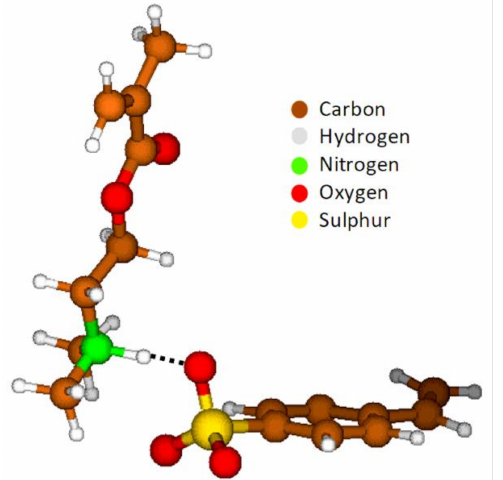
Figure 3. Geometrical feature of NaSS and DMAEMA ionic monomers in water.